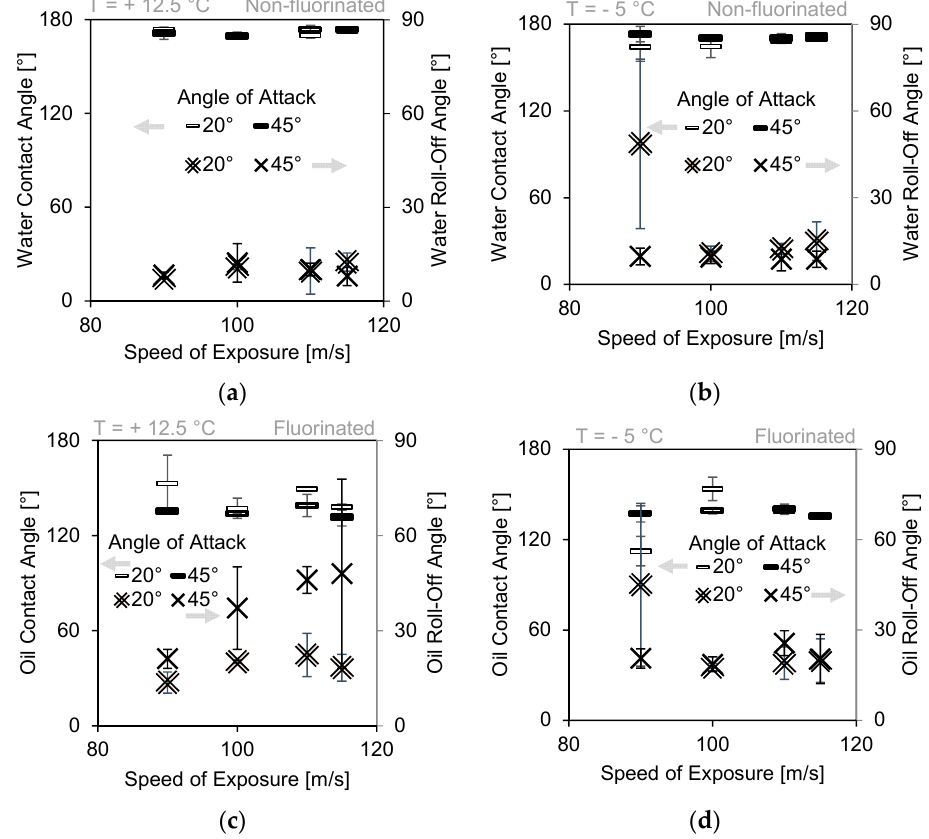
Figure 6. Wetting properties of fabrics exposed to cloud conditions for 10 min at increasing speeds while on a flat plate at an angle of attack of 20 ◦ (horizontal dash) and 45 ◦ (cross). ( a ) Water droplets on a superhydrophobic fabric after exposure at + 12.5 ◦ C. ( b ) Water droplets on a superhydrophobic fabric after exposure at − 5 ◦ C. ( c ) Oil droplets on a superamphiphobic fabric after exposure at + 12.5 ◦ C. ( d ) Oil droplets on a superamphiphobic fabric after exposure at − 5 ◦